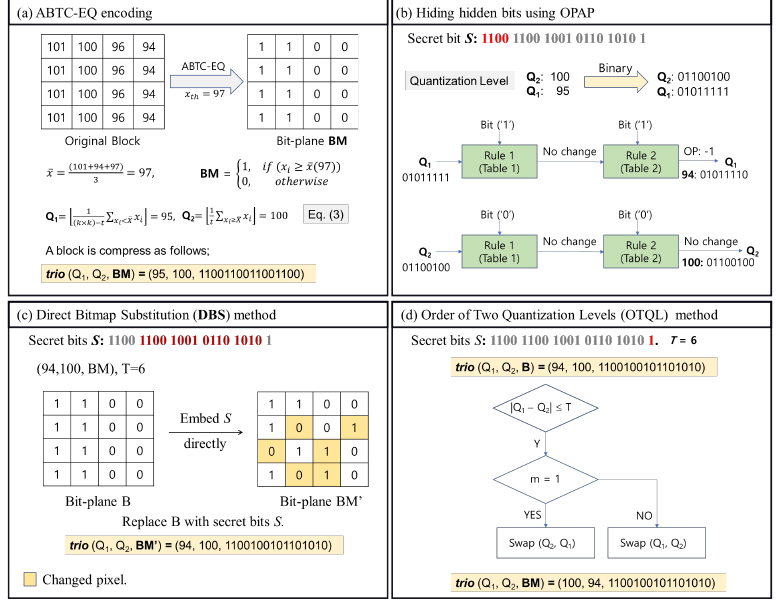
Figure 3. Example of data hiding based ABTC